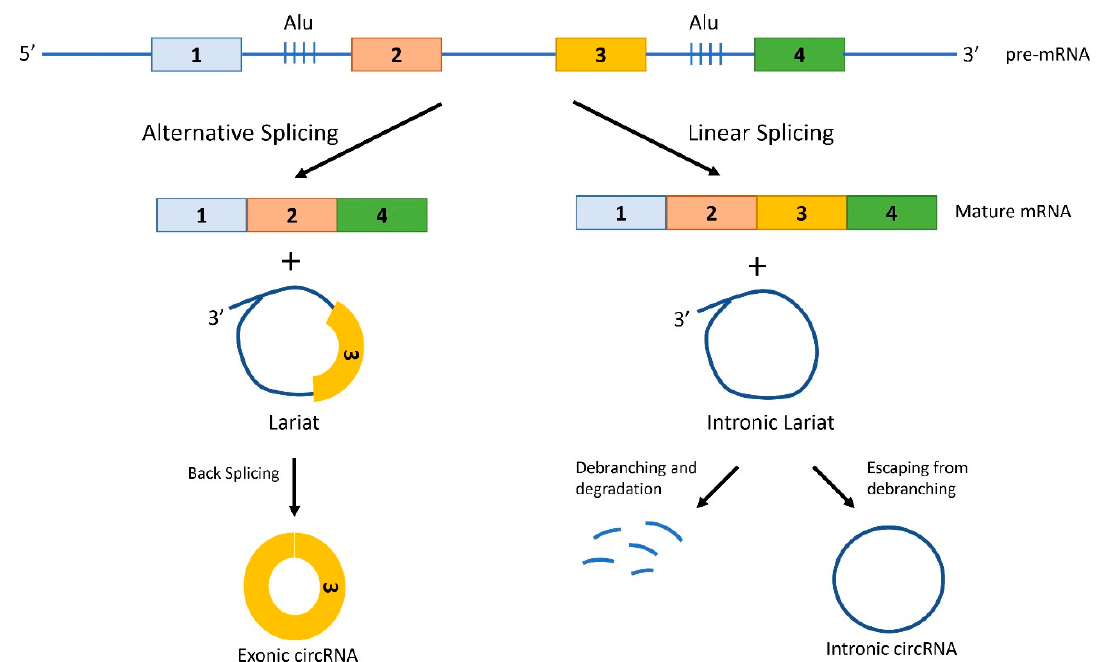
Figure 2. Generation of circRNAs from lariats. Lariats are lasso-shaped molecules that originate from pre-mRNAs during both alternative splicing and linear splicing. Lariats are formed when a 5 ′ end of a spliced intron is joined with a covalent bond to the BP adenosine of the intron. The lariat can either be linearized by specific RNA lariat debranching enzymes and thus be degraded, or escape debranching and form a stable circular transcript upon trimming of the 3 ′ linear tail. When lariats originate from linear splicing, they only contain introns and if they escape debranching, they produce Intronic circRNAs. However, lariats can also originate from alternative splicing, and therefore contain alternative exons together with the introns. Back splicing of hybrid exon-intron lariats generates Exonic circRNA.